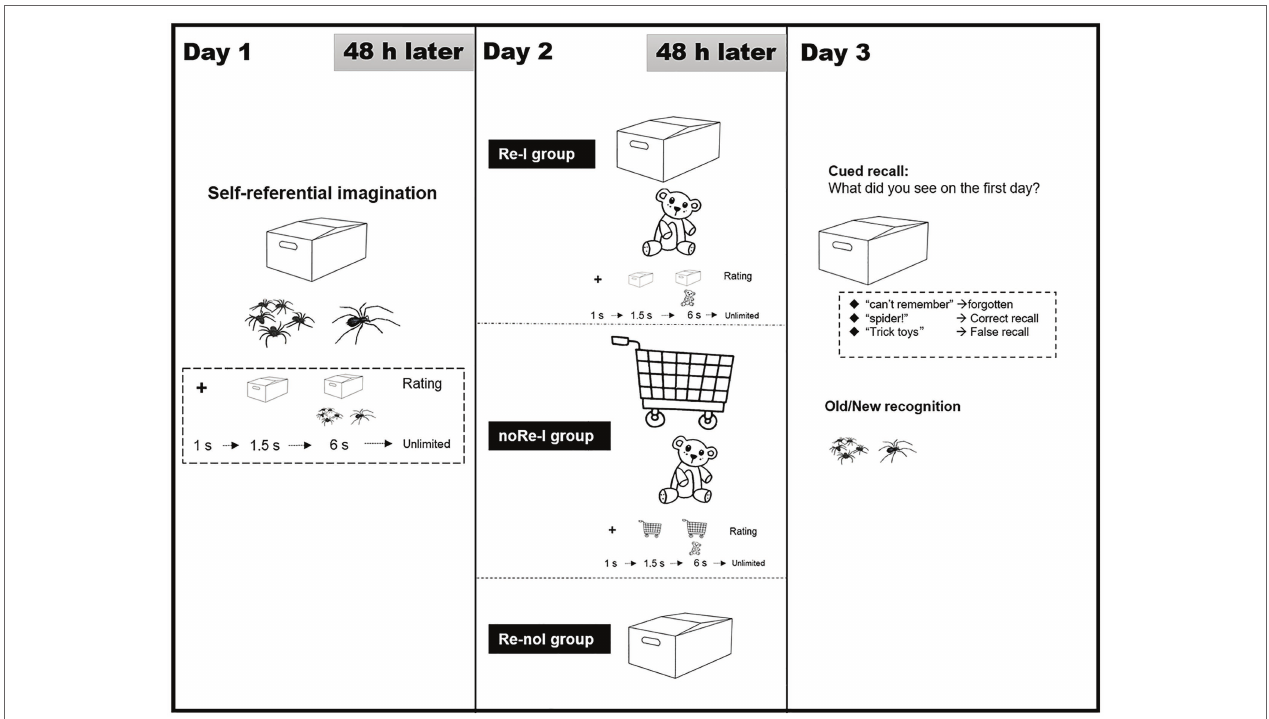
FIGURE 1 | Program flow diagram of Experiment 1. The experiments consisted of three experimental sessions (learning, interfering, and testing) with 48-h intervals between each. On Day 1, all the participants learned a series of negative scenarios (each one consists of the cue object/background and the core object) trial by trial through self-referential simulation, and rated self-involvement level. On Day 2, the participants were divided into three groups randomly: (a) Reactivation- Interference group, Re-I, in which the first-day memory was reactivated on the participants via the presenting the same cues as Day 1 and it interfered with the rematch scenarios with old cues and novel objects; (b) Reactivation-no Interference group, Re-noI, in which the first-day memory was reactivated on the participants via presenting the same cues as Day 1, but no novel information were additionally presented; and (c) no Reactivation-Interference group, noRe-I, in which the